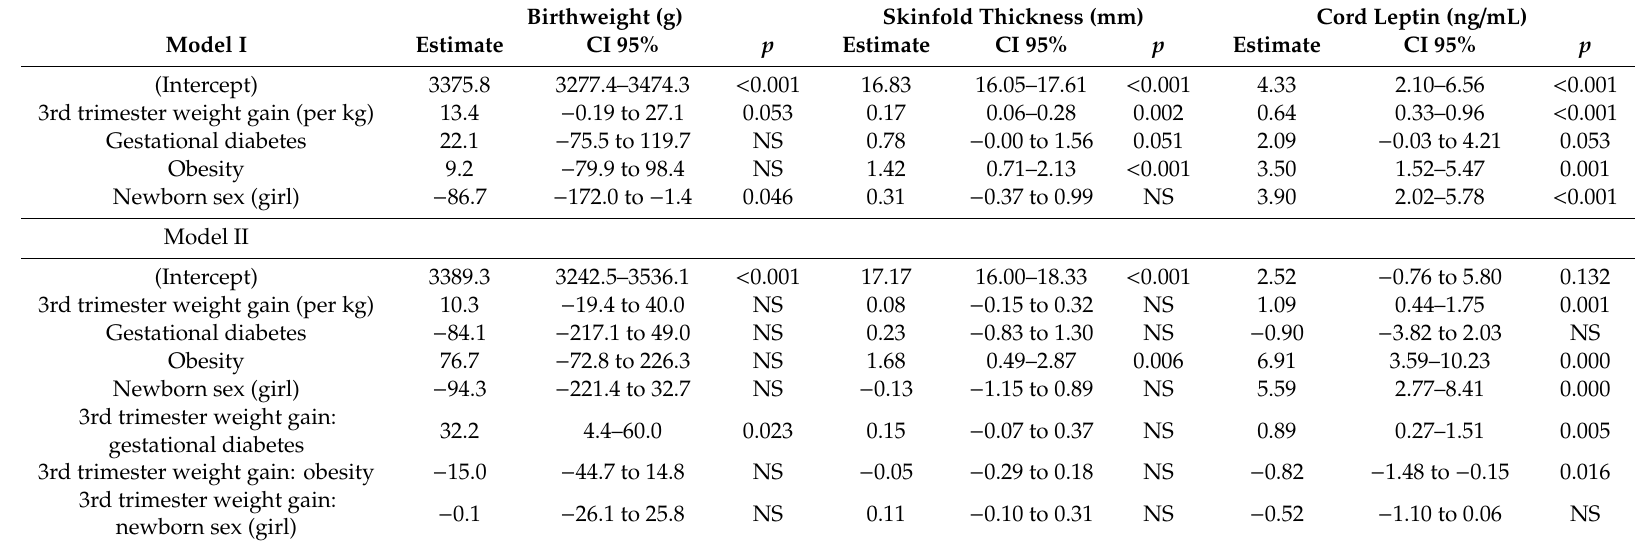
Table 3. Contribution of third trimester gestational weight gain on birth weight, skinfold thickness, and cord leptin